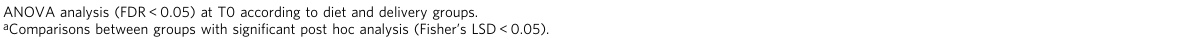
F value P value − LOG10(p) FDR Fisher ’ s LSD a